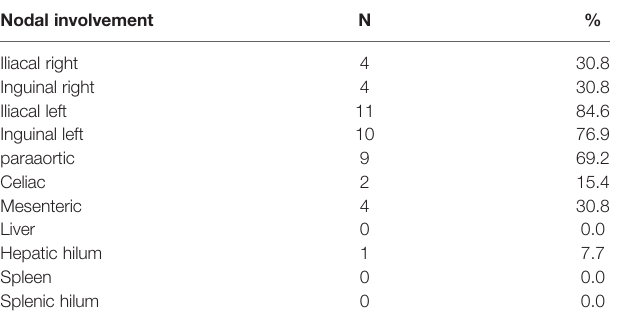
TABLE 4 | Initial nodal involvement. Nodal involvement